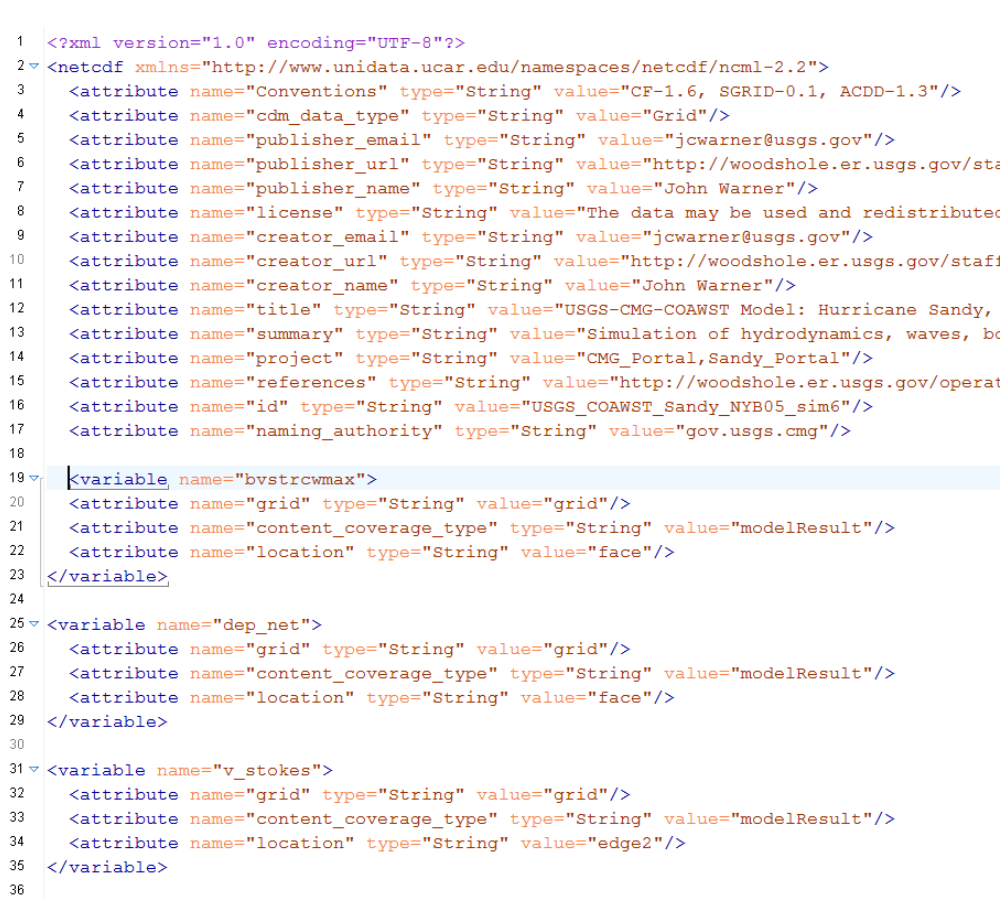
Figure 8. A sample NcML file produced by the yaml2ncml.py Python script. Although these files can be created by hand using a text editor, getting validated NcML has proven difficult for modeller, and the yaml2ncml pathway has been found to be less error prone. This NcML file not only specifies attributes but also contains a regular expression that specifies which NetCDF files should be part of this aggregated data set (not